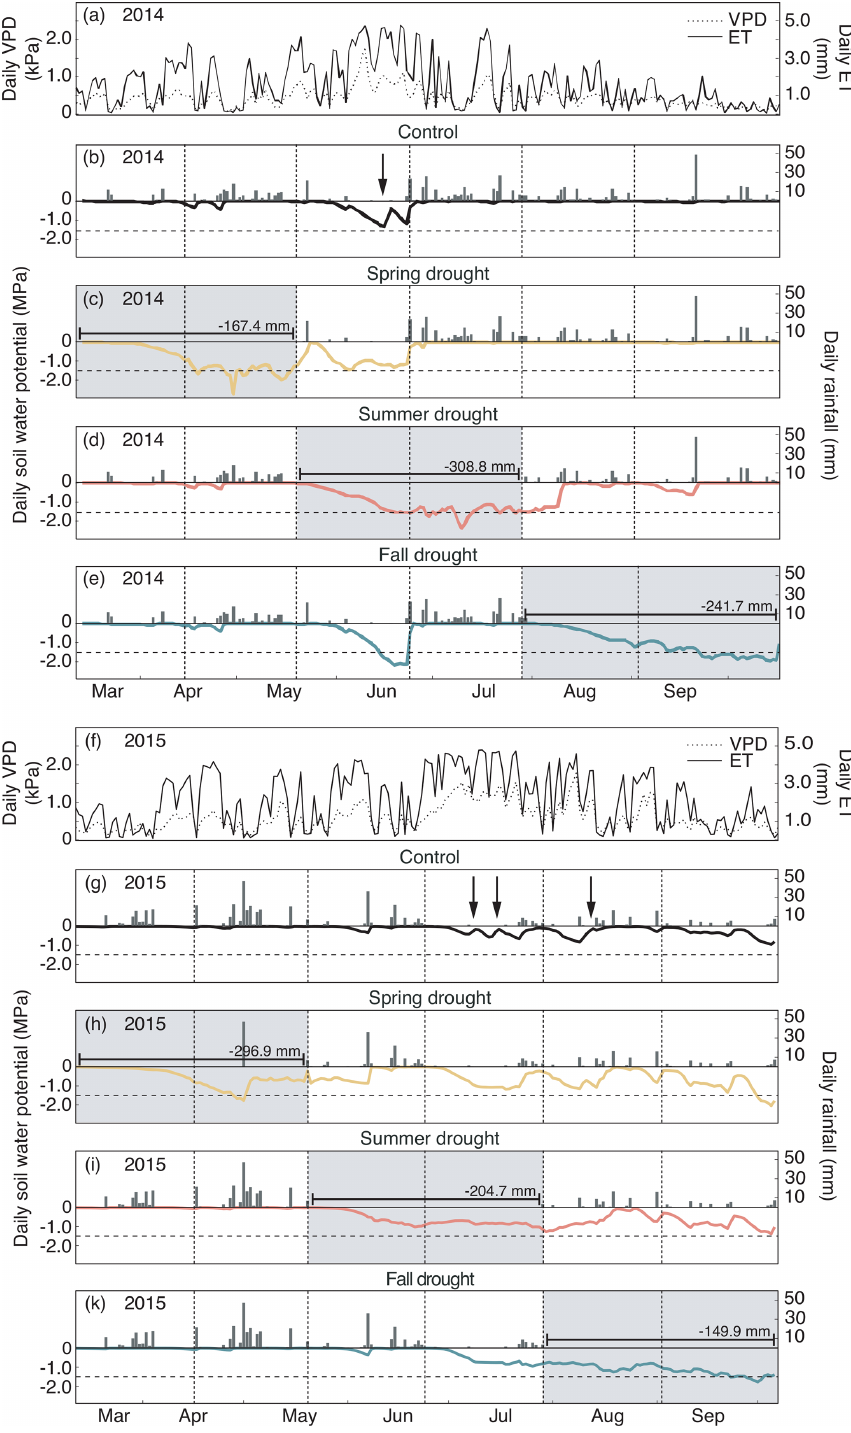
Figure 2. (a, f) Daily evapotranspiration (ET) and vapor pressure deficit (VPD). (b–e, g–k) Daily rainfall and soil water potential ( (cid:57) Soil ) in 10cm depth over the growing seasons 2014 (a–e) and 2015 (f–k) for the control and drought treatment (sensors per treatment – n = 8). Gray shading represents the experimental drought when rainfall was excluded. Dashed horizontal line shows the permanent wilting point ( (cid:57) Soil = − 1.5MPa). Dashed vertical lines represent the dates of the harvest. Arrows indicate the watering events (in control plots only).